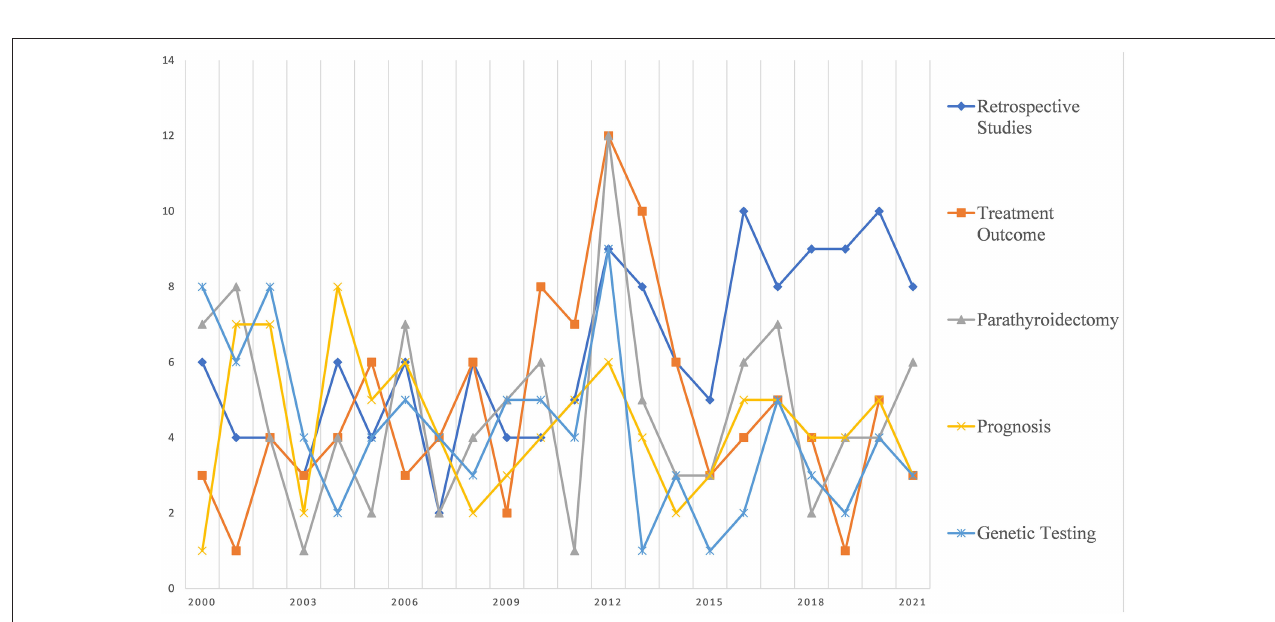
FIGURE 3 | Research foci trends related to clinical